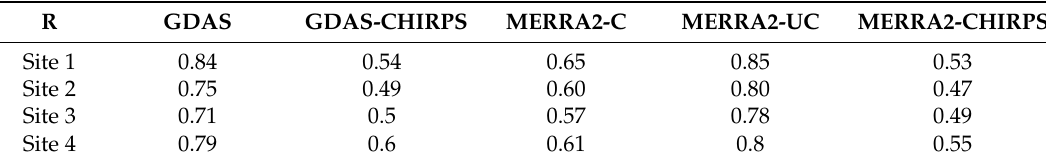
Figure 10. The correlation coefficient between modeled streamflow and observed daily streamflow in 2014 for stations along the Indus river and its tributaries, which is shown in Figure 7. Table 3. The Pearson correlation coefficient (R) between the water level height and the stream flow at four altimetry sites over the Indus river basin.